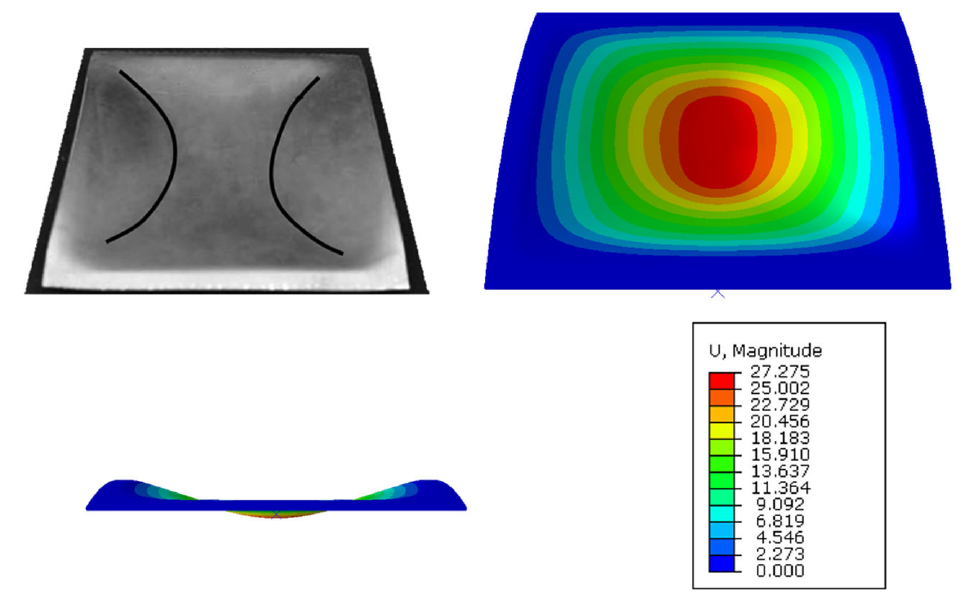
Figure 10. A comparison of the deformation and failure patterns of the aluminum panel of experiment results and numerical prediction.